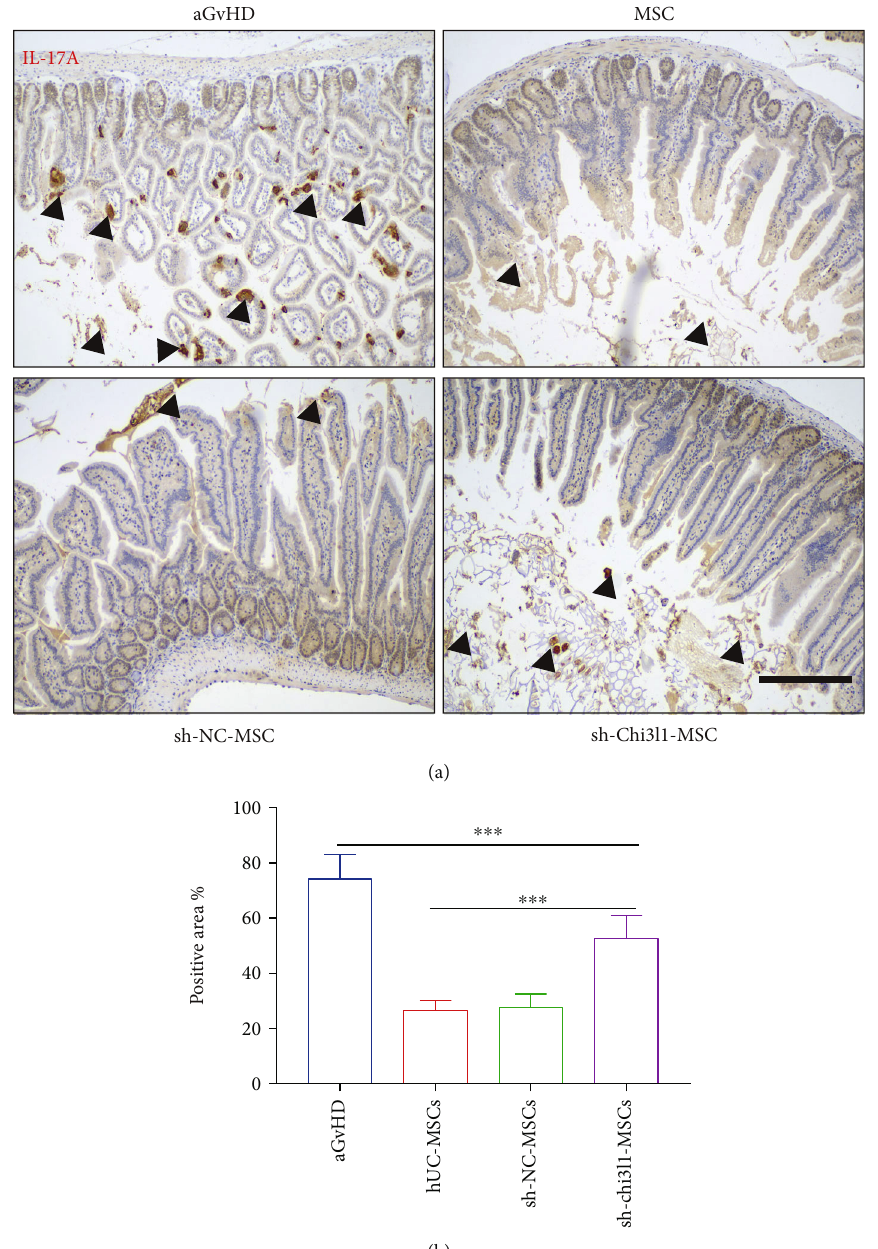
Figure 5: sh-Chi3l1-MSCs failed to repress IL-17A production in the intestine. (a) Intestinal immunohistochemical staining results of aGvHD mice on day 21 after hUC-MSC, sh-Chi3l1-MSC, sh-NC-MSC ( 1 × 10 6 ), or PBS (0.2 ml) treatment. (b) Positive results of IL-17A expression measured using Image-Pro Plus software. Scale bar: 100 μ m, n = 7 , three independent experiments, one-way ANOVA, and Tukey ’ s multiple comparison test, P < 0 : 001